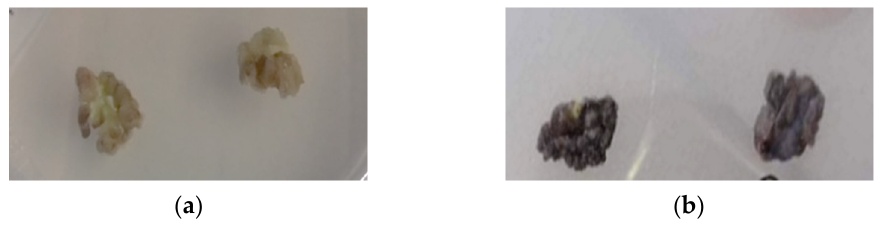
Figure 2. Origanum vulgare leaf-derived calluses. ( a ) Healthy calluses. ( b ) Brown calluses due to oxidation.